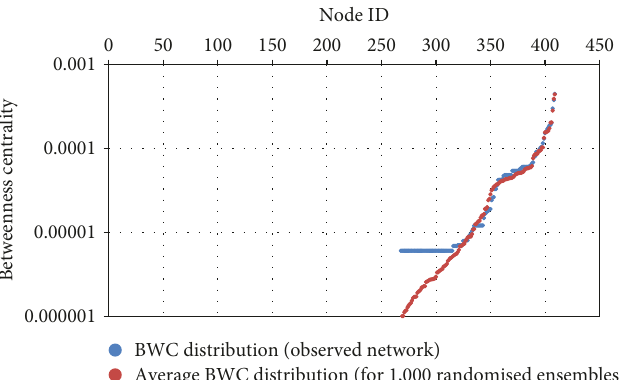
Figure 3: Betweenness centrality distribution of the observed SCN (ref #: 24 — Farm Machinery and Equipment) against the average betweenness centrality distribution obtained from 1000 randomised ensembles.